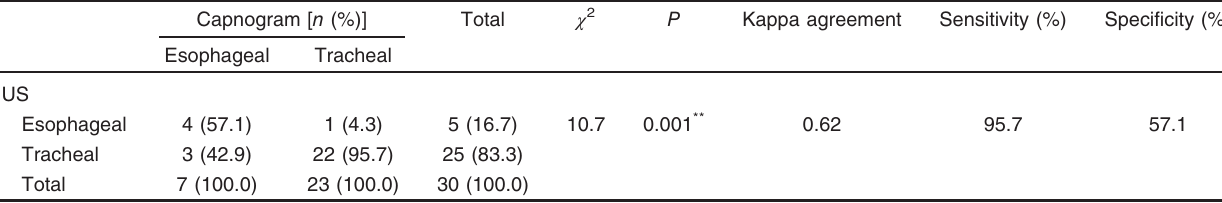
Table 3 The sensitivity and specificity of ultrasonography with regard to capnography as gold standard